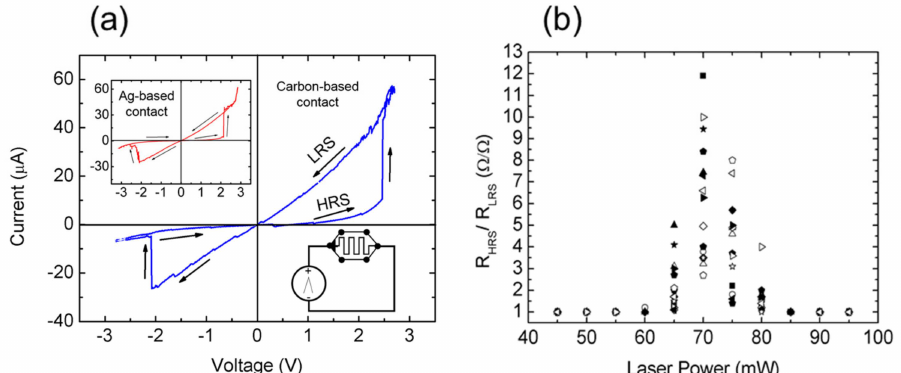
Figure 3. Electrical performance of a laser-reduced GO memristor (P laser = 70 mW, L = 2.2 mm, W = 1 mm). ( a ) Current-voltage characteristic of a memristor showing the characteristic signature of memristance. The voltage has been scanned from − 3 V to 3 V with a voltage step of 10 mV. The